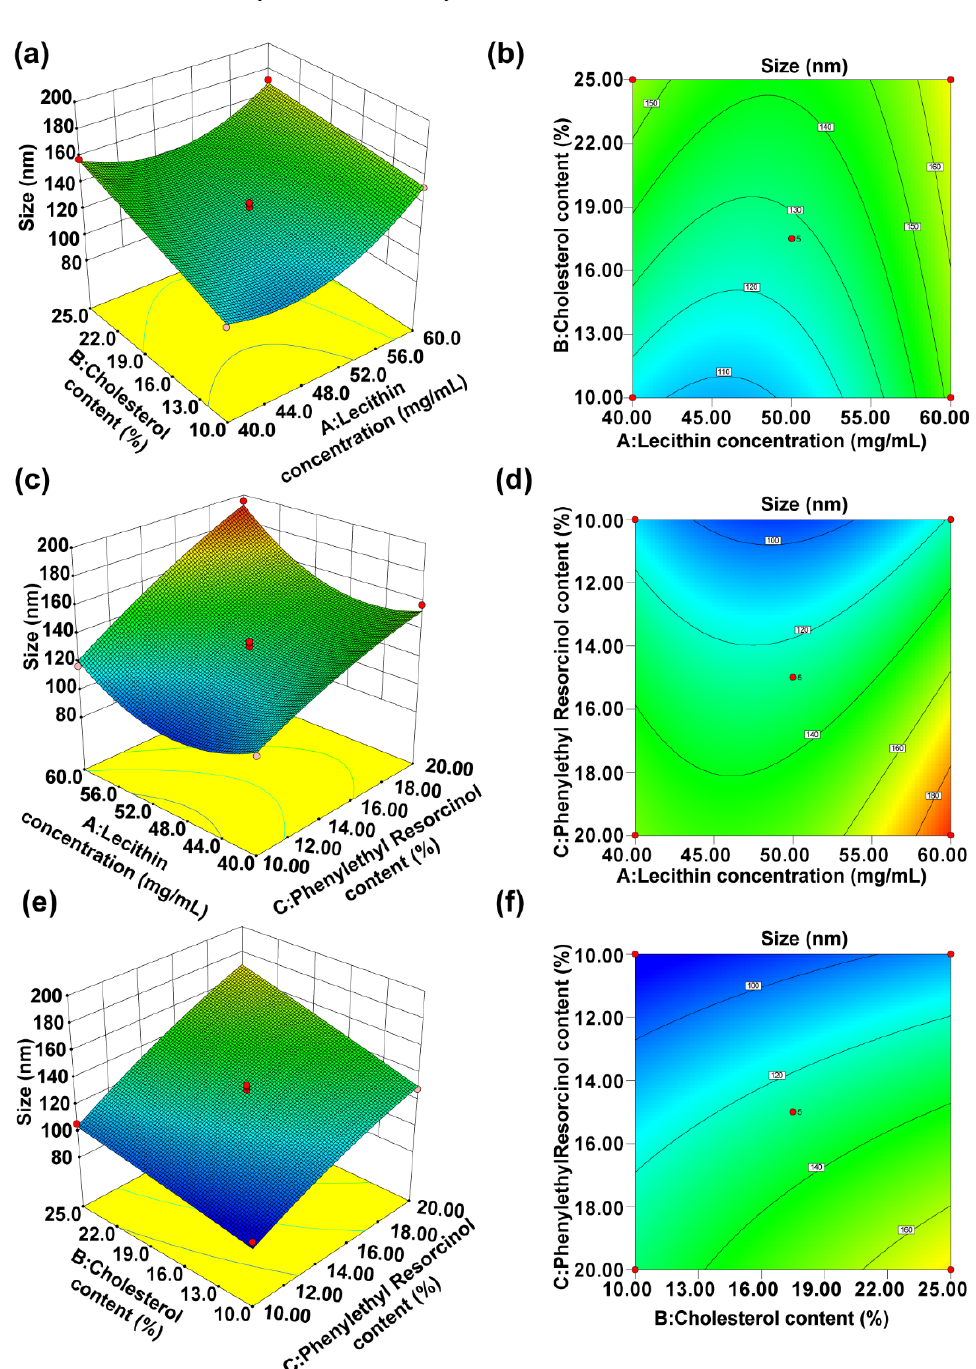
Figure 4. Response surface plots were generated using BBK to show the effect of any two factors on size, while other factors were kept constant at the reference point. 3D response surfaces and 2D contour plots: ( a , b ) the effects of lecithin concentration and cholesterol content on size; ( c , d ) the effects of lecithin concentration and phenylethyl resorcinol content on size; ( e , f ) the effects of cholesterol content and Phenylethyl Resorcinol content on size.